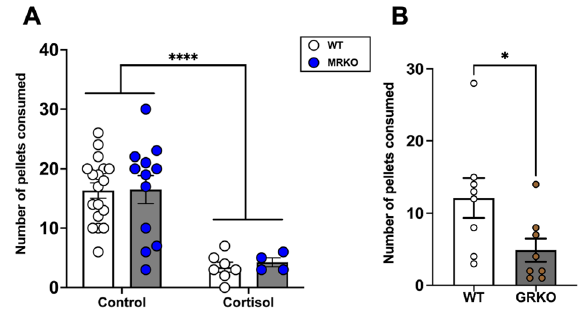
Figure 7. Loss of GR suppresses food intake. ( A ) MRKO fish lacks MR, while GR activation by cortisol treatment reduces the food consumed (control groups of both genotype had 12–18 fish and the cortisol group had 4–7 fish). *Significantly different from the control (2-way ANOVA; P < 0.001). ( B ) In fish lacking GR (GRKO) also the food intake was reduced (n = 8). Values are means ± SEM. ns—not